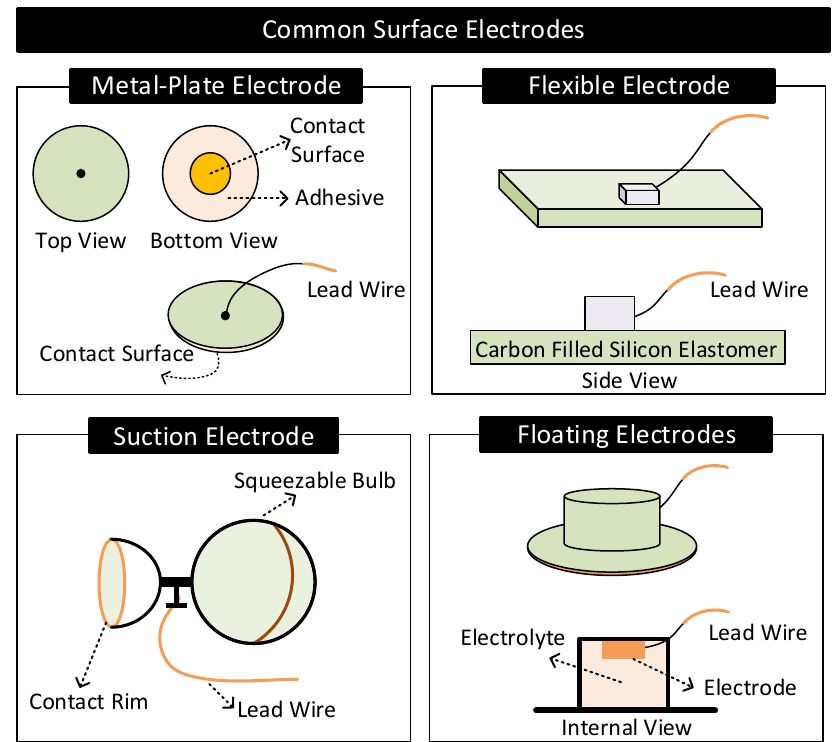
Figure 9. Common surface